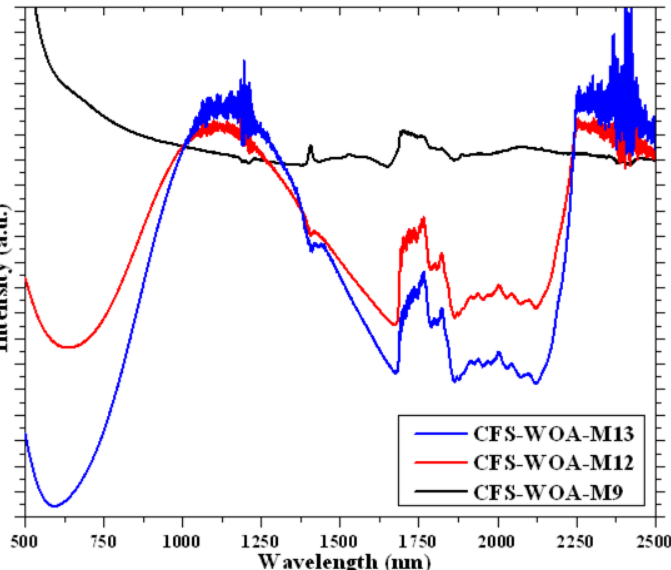
Fig. 7. Optical absorbance spectrum of synthesized CuFeS 2